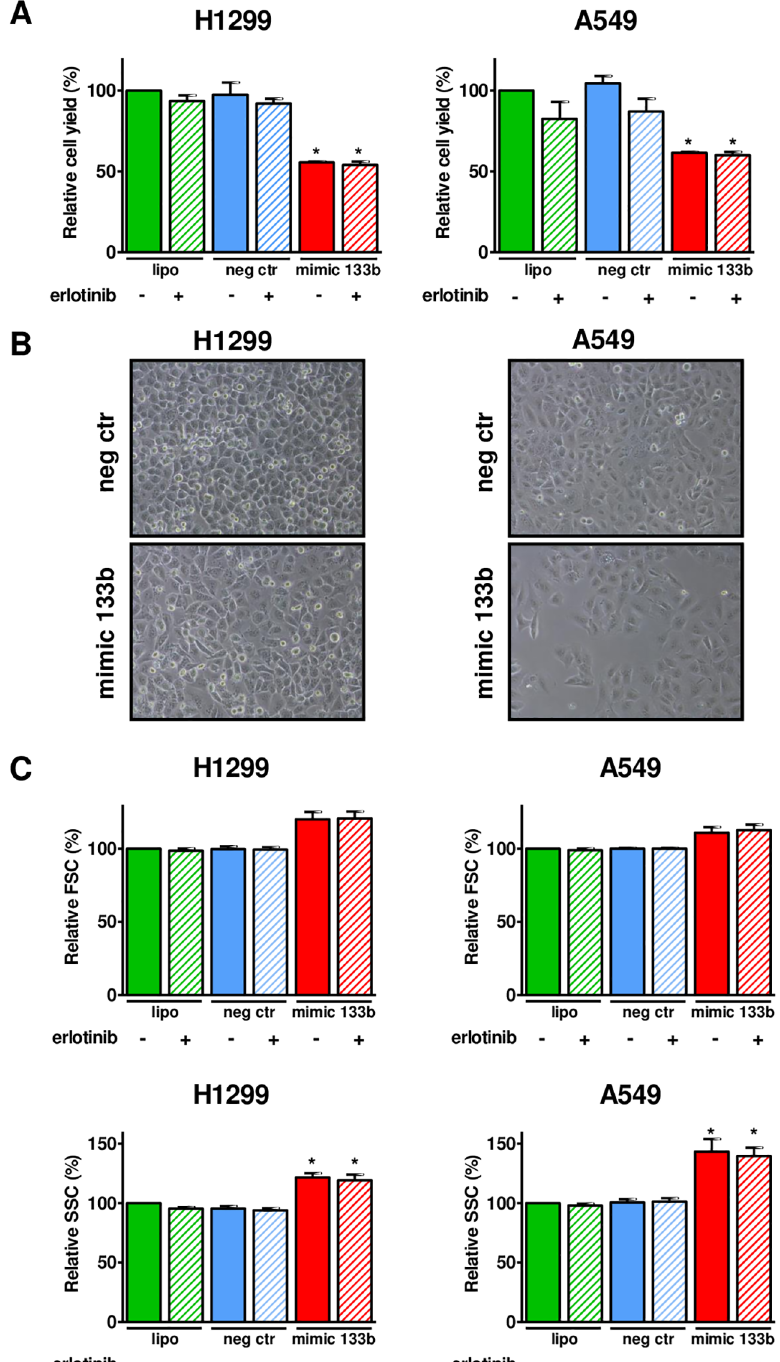
Fig 2. Effects of miR-133b in combination to erlotinib on NSCLC cell lines. Cells were seeded at 1.5 x 10 5 cells/well and cultured up to 72 hours. Data are presented as mean ± SEM of three independent experiments. A Cell growth relative to lipofectamine-treated cells. B Photographs of A549 and H1299 after 72 h treatment. Magnification 400X. C Cell shape measured as forward scatter (FSC) shown on the top and side scatter (SSC) shown on the bottom. Note that the axes in each diagram are displayed in relative percent scale. (cid:3) p < 0.05 by the one sample t test with hypothetical value = 100.